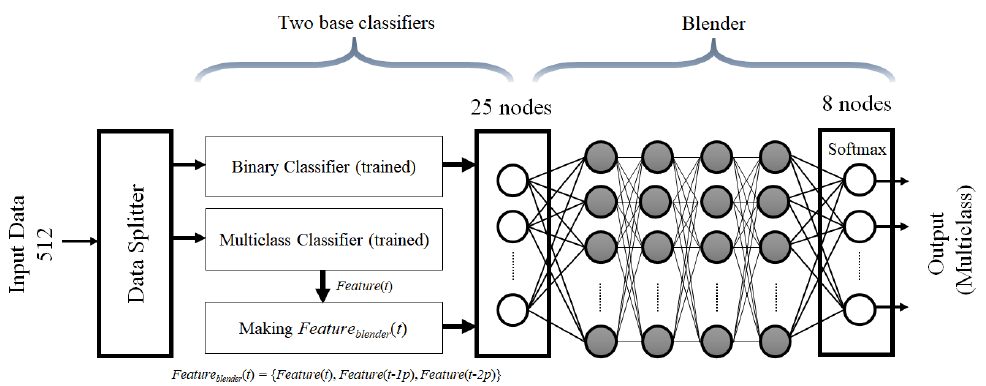
Figure 8. The modified stacking method structure: The outputs of the multiclass classifier are stored for a specific time and these outputs are used for input data to the